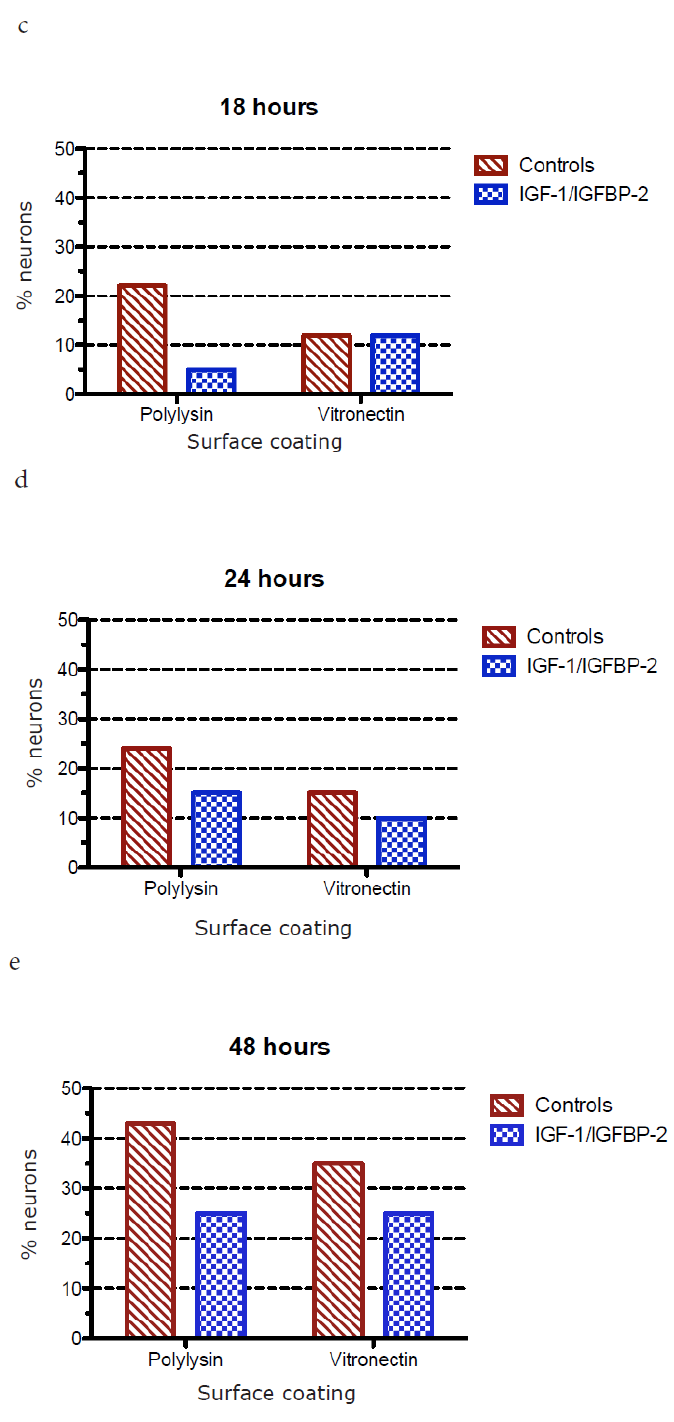
Figure 7. ( a )–( e ) The proportion in percentage of neurons at differentiation stage 3 or higher grown on poly-L-lysin or vitronectin and treated with or without IGF-1/IGFBP-2. Six wells for each treatment and time point were used for measurements and five cells per well were measured. At later time points, there was a trend towards growth on poly-L-lysin without IGF-1/IGFBP-2 treatment being favorable to reaching differentiation stage 3 or